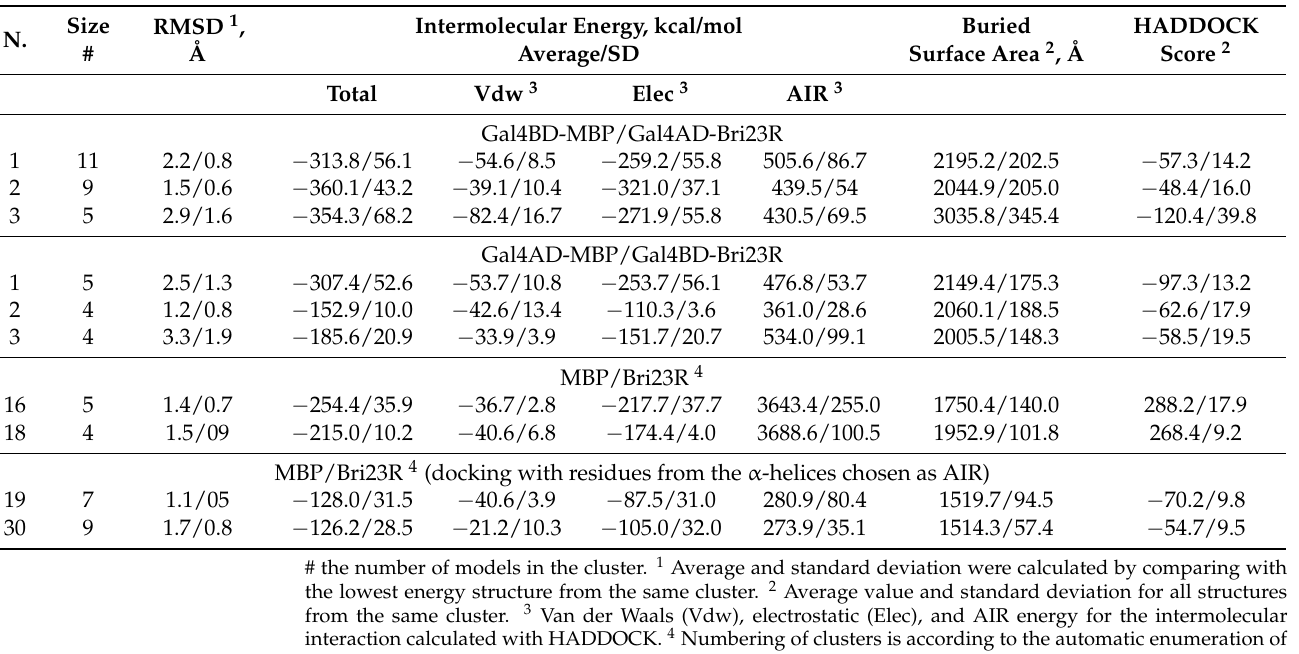
Table 2. Statistical analysis of the lowest energy clusters obtained for the best 30 HADDOCK- generated complexes.